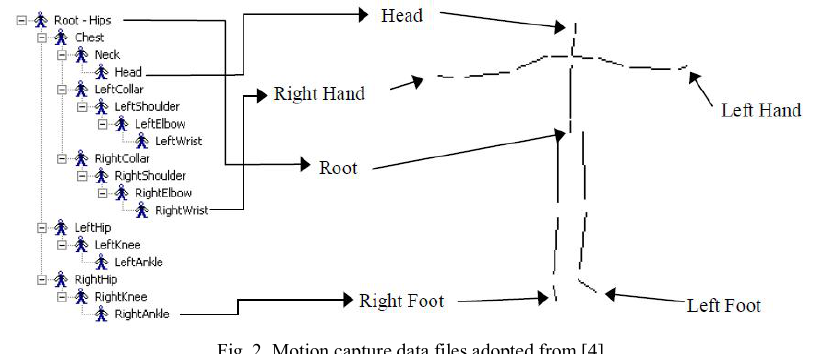
Fig. 2. Motion capture data files adopted from